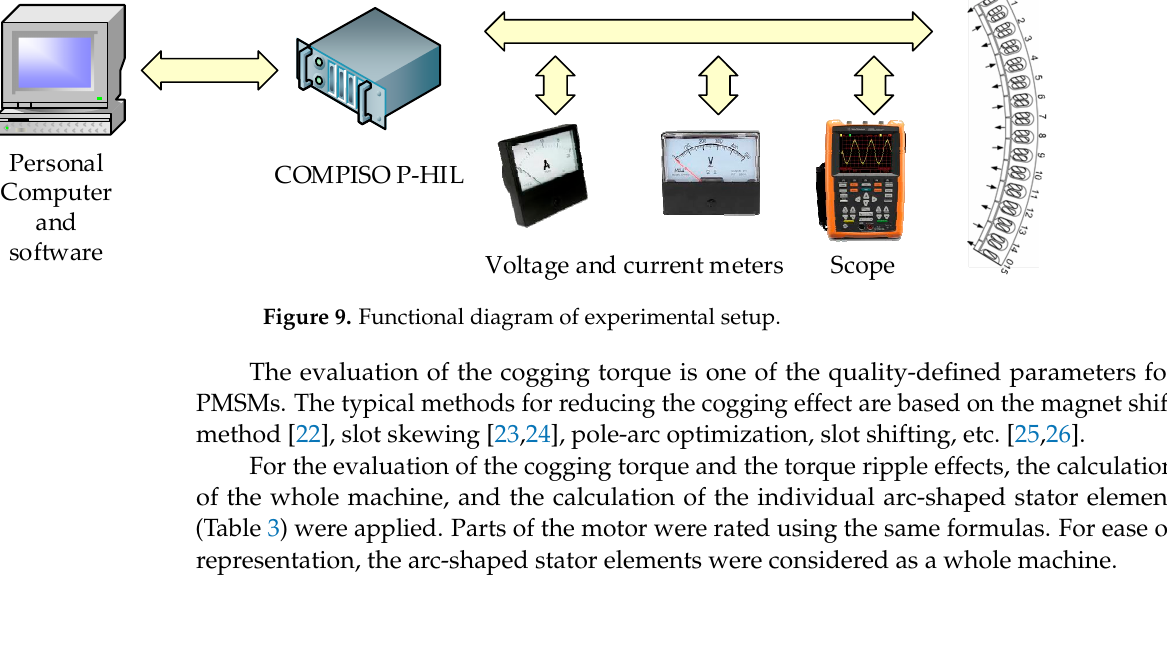
Table 3. Motor and Segment Data.